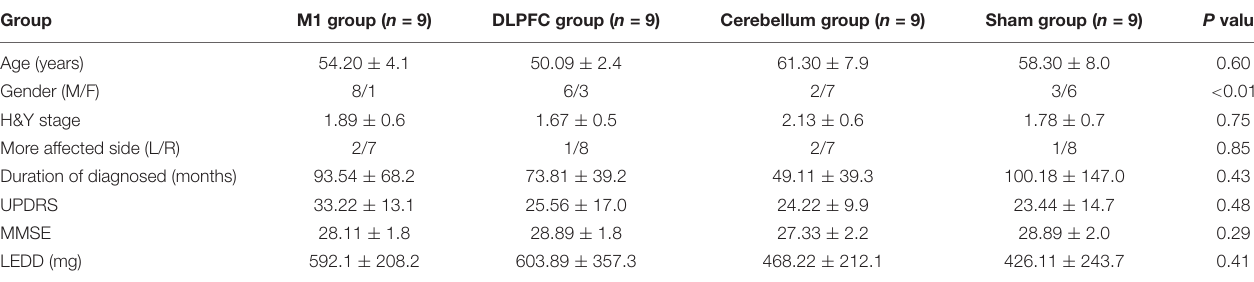
TABLE 1 | Demographic characteristics of included participants with Parkinson’s disease.